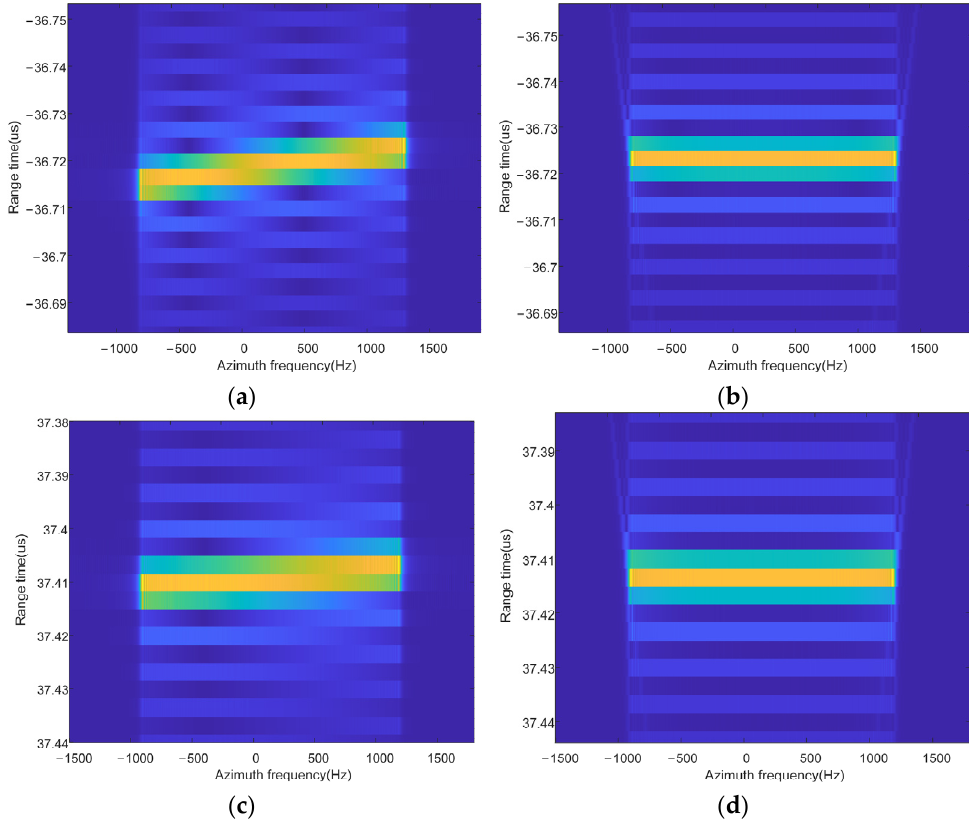
Figure 7. The results of the range processing. ( a ) Range processing the echo of the target P − using the traditional NLCS algorithm; ( b ) Range processing the echo of the target P − using the proposed method; ( c ) Range processing the echo of target P + using the traditional NLCS algorithm; and ( d ) Range processing the echo of the target P + using the proposed method.